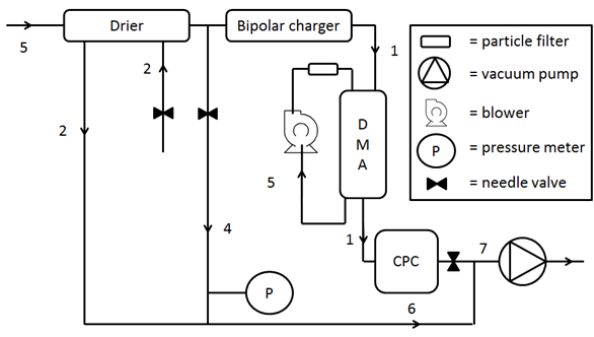
Figure 3. The drier and the SMPS configuration. Numbers are de- noting flow rates in Lmin − 1